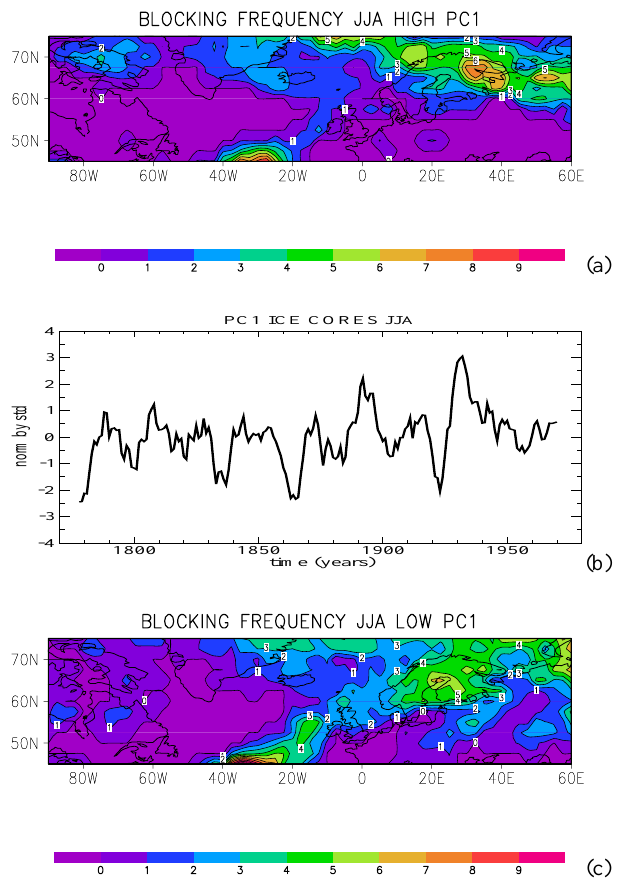
Fig. 15. (a) Blocking frequency composite for (a) high PC1 and (c) low PC1 of summer Greenland stable isotope records (Vinther et al., 2010). (b) Filtered (7-year running mean) PC1 of summer Greenland stable isotope time series for 1778–1970